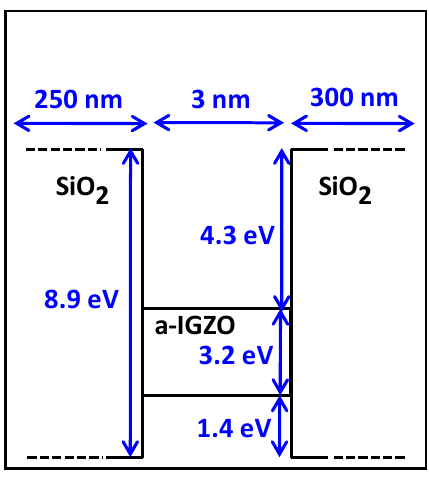
Figure 10. Band offsets between amorphous indium-gallium zinc-oxide (a-IGZO) and SiO 2 .